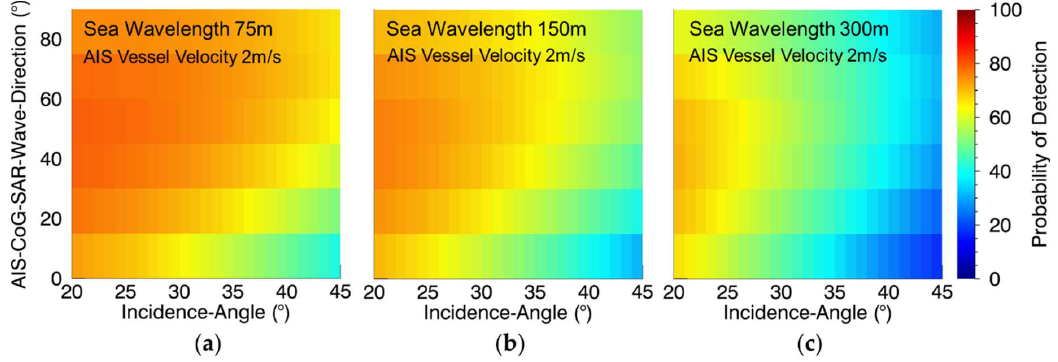
Figure 6. 2D detectability charts based on Incidence-Angle, AIS-CoG-SAR-Wave-direction and from left to right SAR-Significant-Wave-Length with: ( a ) 75 m, ( b ) 150 m, and ( c ) 300 m, deviating from the default setting for this chart AIS-Vessel-Velocity was set to 2 m/s.